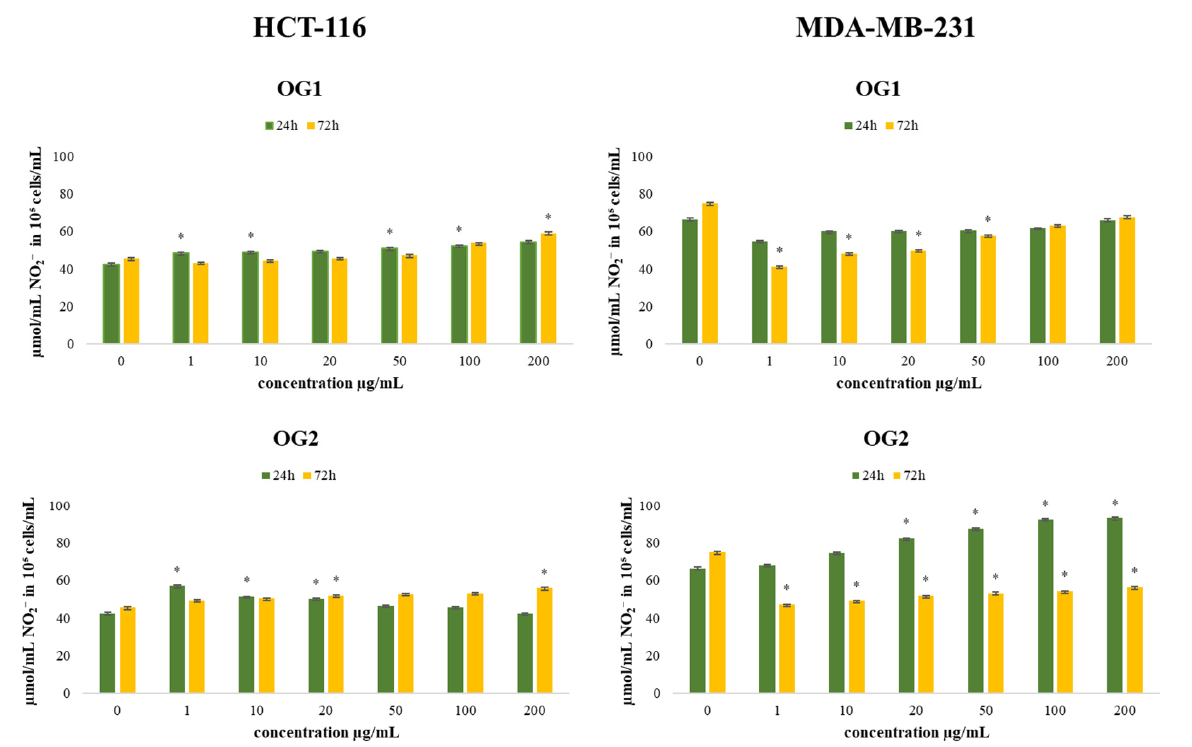
Figure 7. Effects of six concentrations of essential oils on the concentration of NO 2 − in HCT-116 and MDA-MB-231 cells after 24 and 72 h of treatment. Results are presented as the mean of three independent experiments ± standard error; * p < 0.05 relative to control.